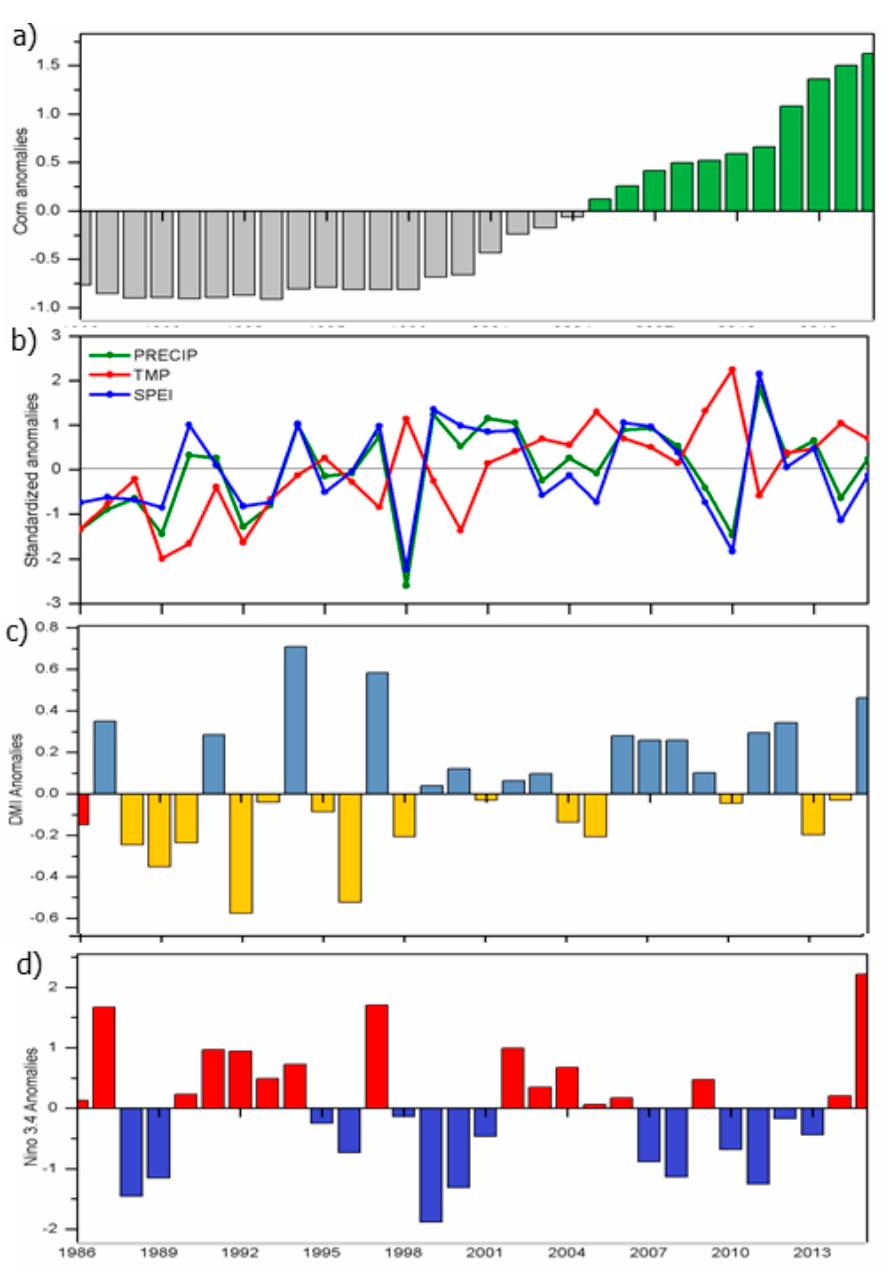
Figure 12. Same as Figure 11 but for Corn production anomalies.